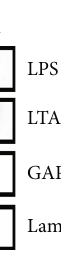
Figure 3: LPS was positive in the nuclear fraction of the liver tissues. Western blotting determined the expression patterns of the tested LPS in the rat livers. Full length gels/blots were cropped from di ff erent parts of the same